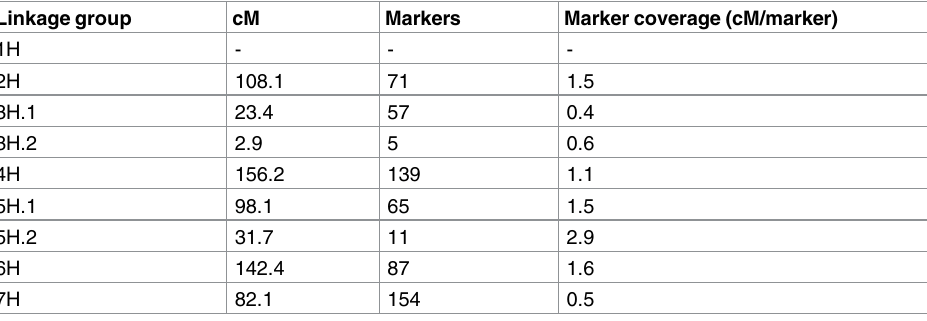
Table 3. SNP coverage and distribution across all chromosomes after